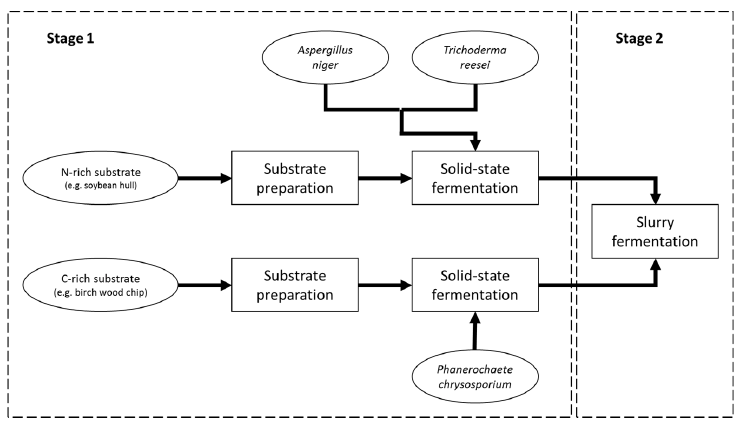
Figure 1. Sequential solid-state fermentation and slurry fermentation for direct succinic acid production from biomass using mixed fungal